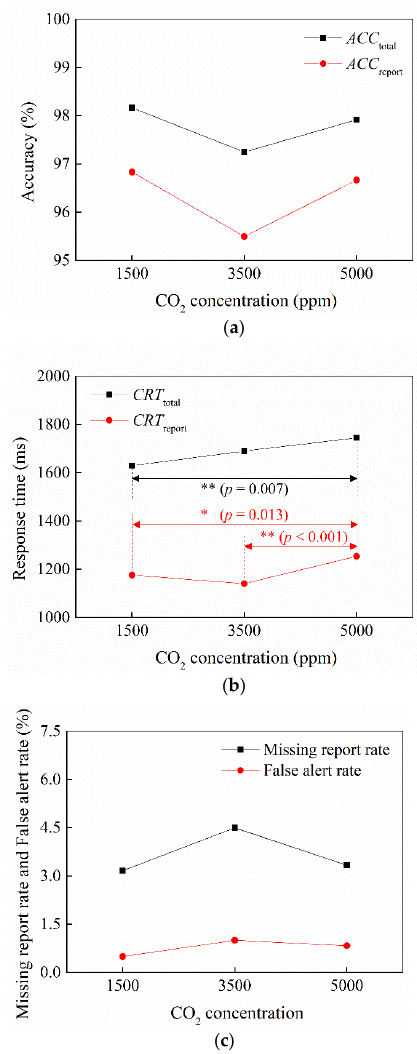
Figure 4. Performance metrics of the VS test under different CO 2 conditions; * ( p < 0.05), ** ( p < 0.01). ( a ) Accuracy. ( b ) Response time. ( c ) Missing report rate and false alert rate.